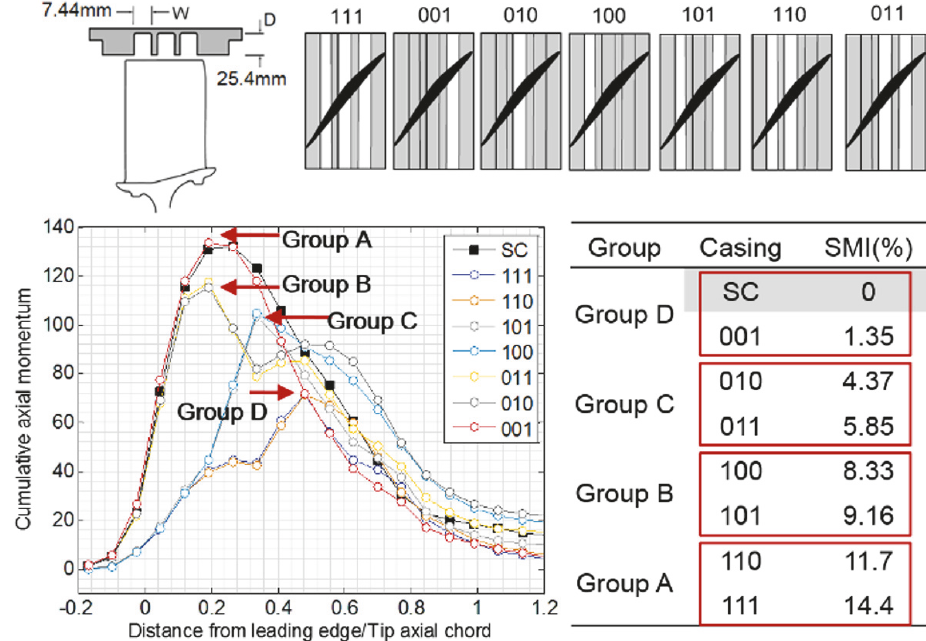
Figure 16: The bell curves for prediction of VCT ([17]). Figure reproduced from NAN (2014).